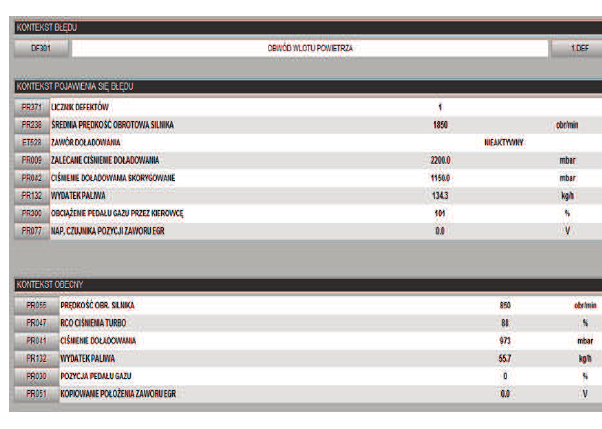
Fig. 2. Frozen frame recording when DF 301 error occurs